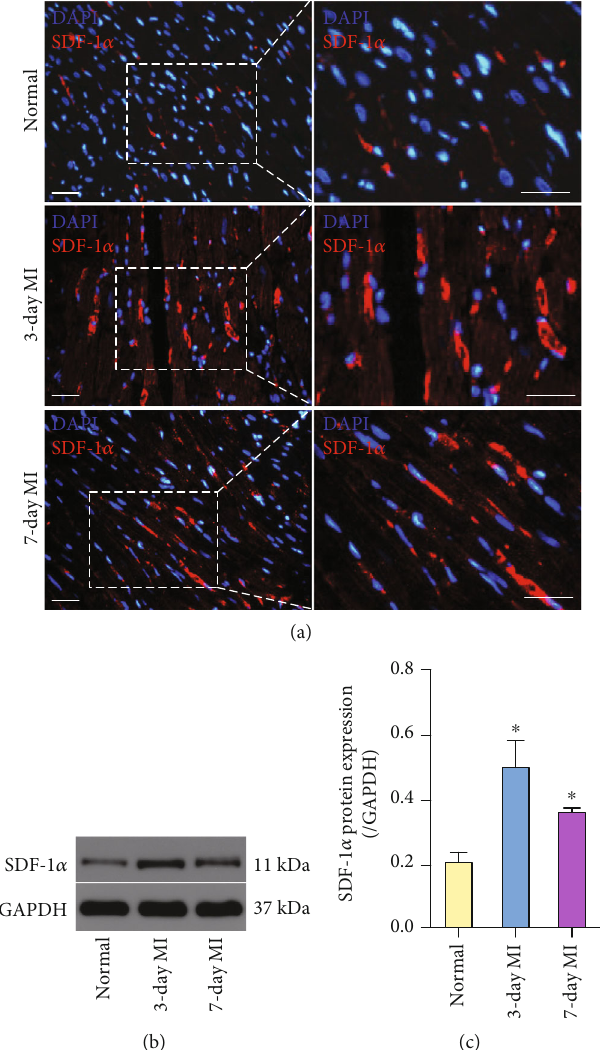
Figure 1: SDF-1 α was upregulated in infarcted myocardium. (a) SDF-1 α (red) was substantially observed on the vessel wall in infarcted myocardium at 3 and 7 days after myocardial infarction, which was scantly expressed in remote normal myocardium. (b, c) The protein expression of SDF-1 α in infarcted myocardium peaked at 3 days after myocardial infarction and remained elevated at 7 days after myocardial infarction relative to remote normal myocardium. Scale bar represents 50 μ m. ∗ p < : 05 versus remote normal